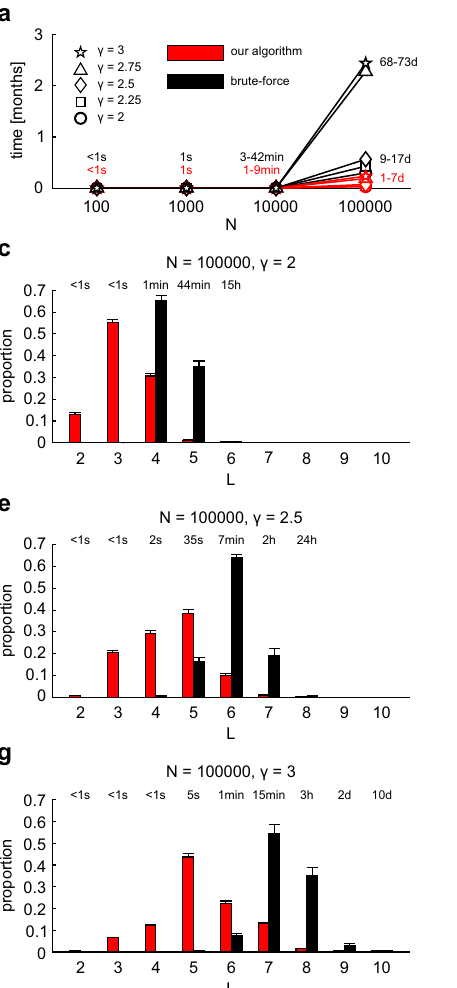
networks of size N = 100,000. In addition, on top of the barplots, we report the mean running time required to reach each recursion depth. d , f , h The panels report, for γ = [2, 2.5, 3] respectively, the running time that would be required to compute the recursive section of the algorithm for each recursion depth and without considering parallel computation, both for our algorithm and brute-force, onnetworksofsize N =100,000.Inallpanels,valuesareaveragedover10network realizationsanderrorbarsareshown,exceptforpanel( a )duetovisualoverlapwith the symbols. For more details, please refer to the dedicated section Supplemen- tary Note